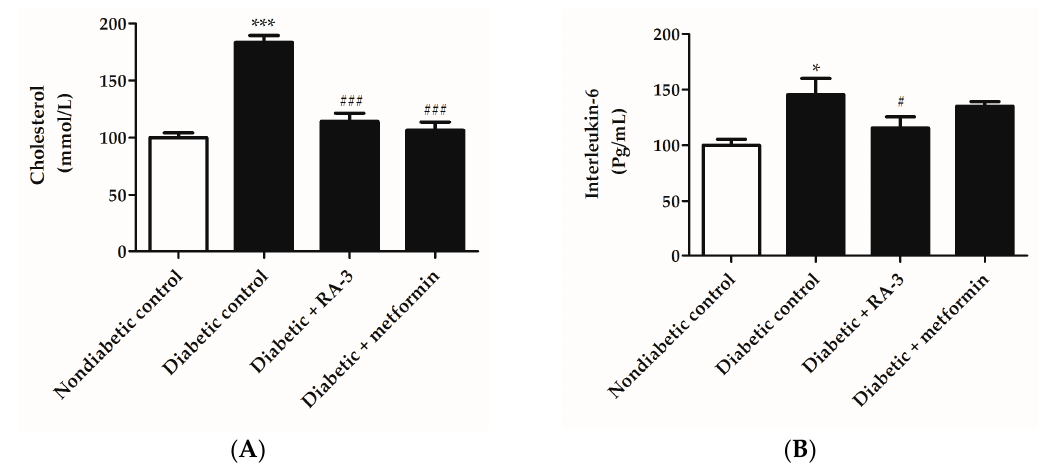
Figure 3. The effect of RA-3 on ( A ) plasma cholesterol and ( B ) serum interleukin-6 (IL-6) levels in the high fat diet and streptozotocin-induced type 2 diabetic rats. Results are expressed as the mean ± SEM and each treatment group contained at least five rats. * p ≤ 0.05, *** p ≤ 0.0001 vs. non-diabetic control, # p ≤ 0.05, ### p ≤ 0.001 vs. diabetic control. One way analysis of variance (ANOVA), followed by a Tukey post-hoc test (Graph Pad Prism version 5.03) were used to determine statistical differences. The values were considered statistically significant where p ≤ 0.05.